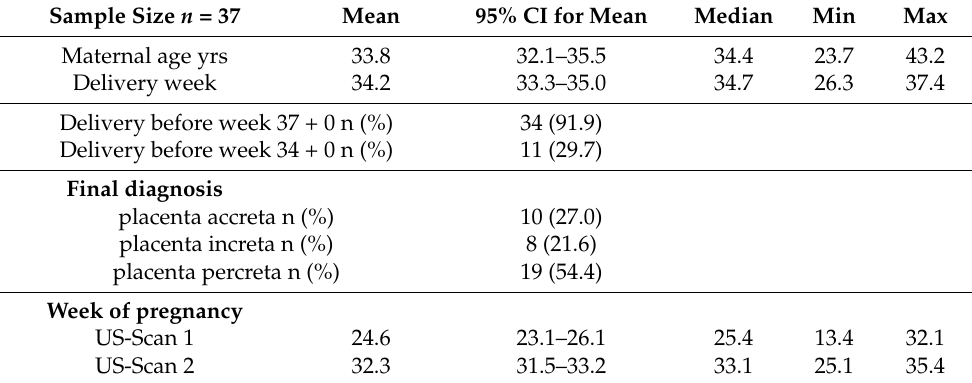
Table 2. Maternal and gestational characteristics & final